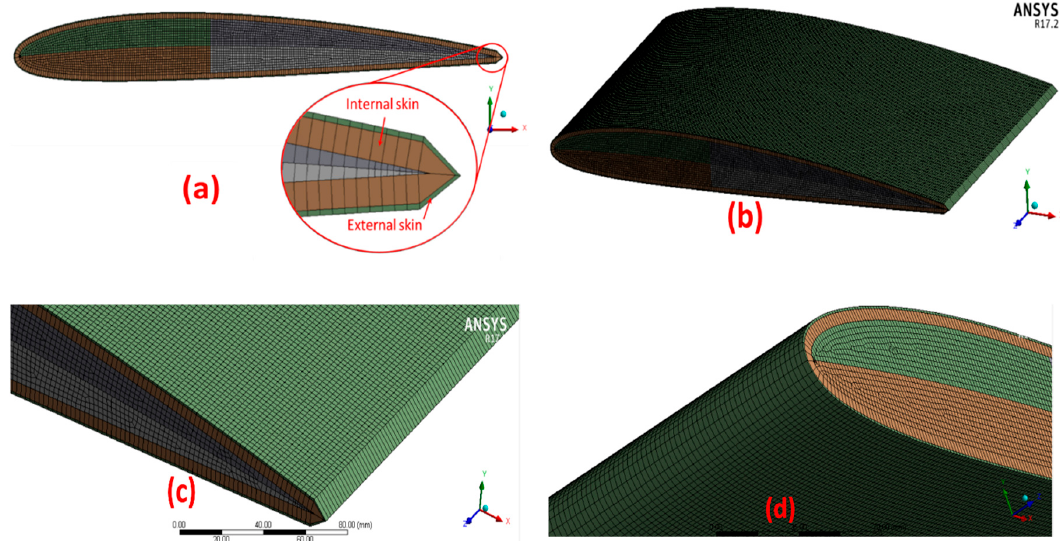
Figure 5. ( a ) FE (Finite Element) model of two-layered skin; ( b – d ) meshed model.